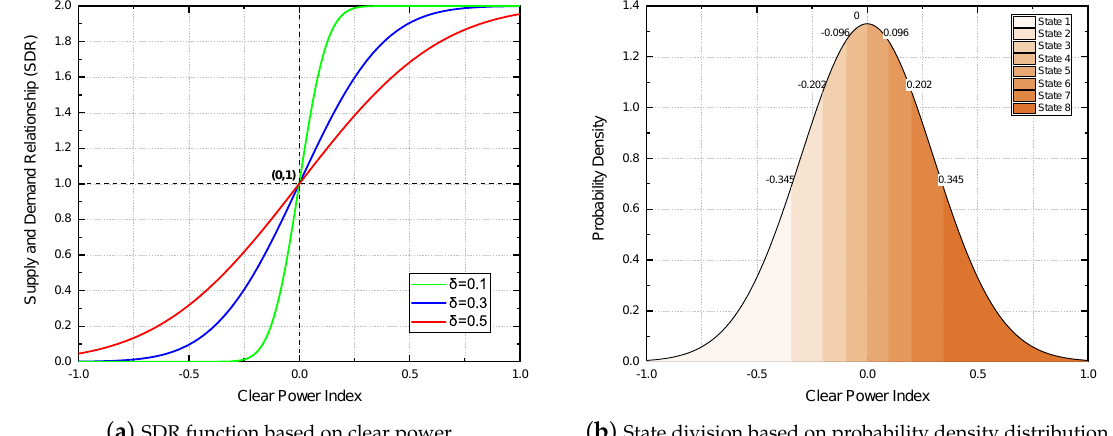
Figure 5. Supply and demand relationship function and state division of the proposed Q-cube